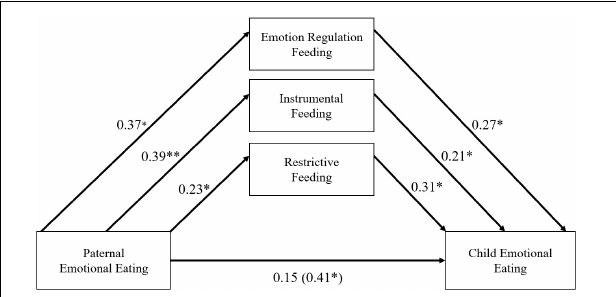
FIGURE 3 | Standardized regression estimates for father’s conditional effects. * p < 0.05, ** p < 0.001. Covariates included parent stress, parent negative affect, child age, and child gender on all model paths.